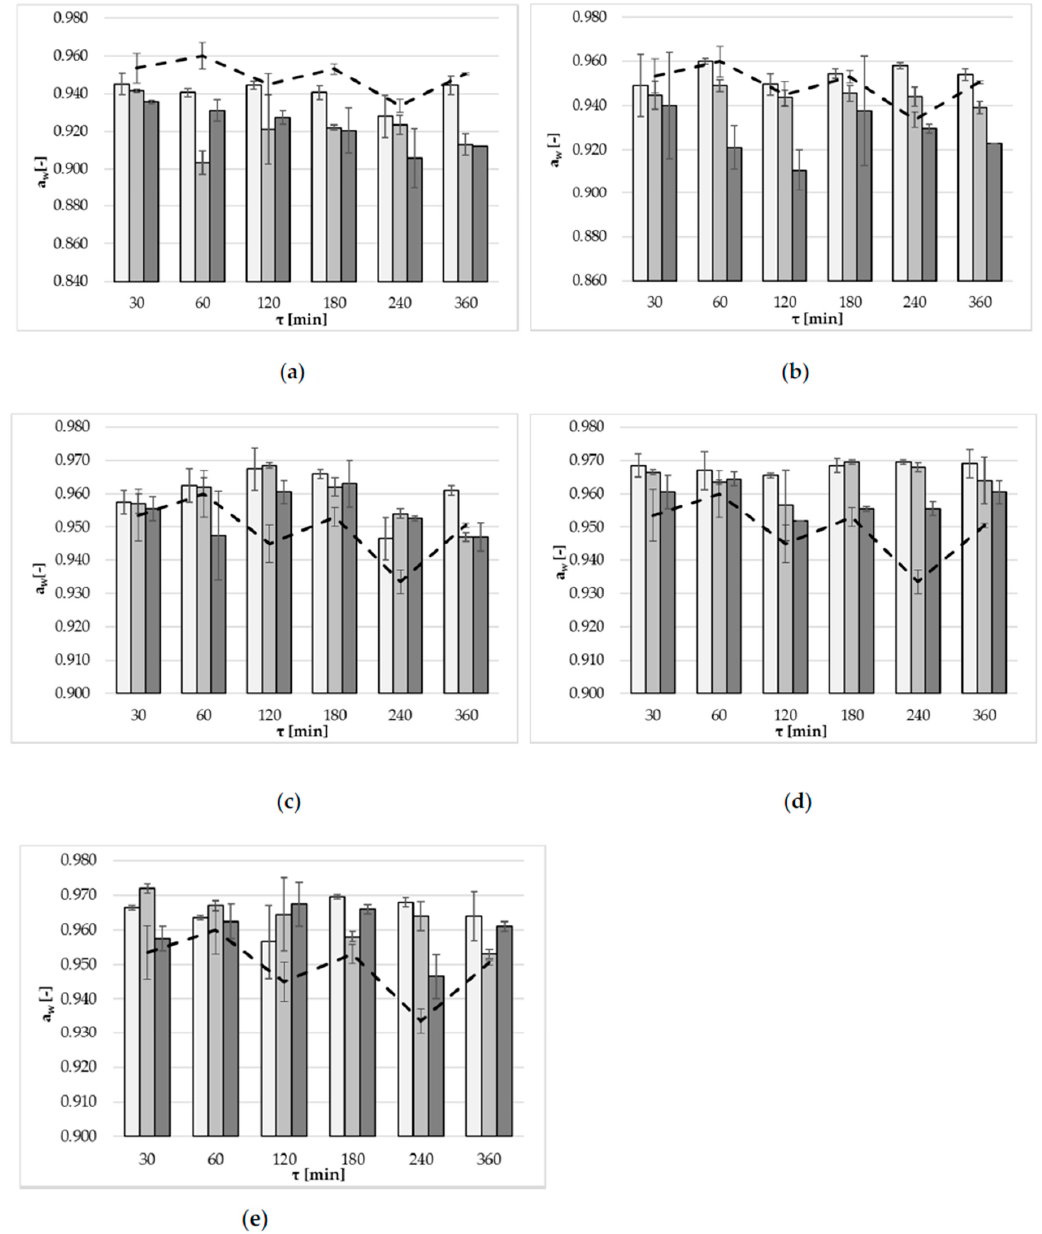
Figure 3. Water activity, a w , at several concentrations: 20 (light grey bars), 30 (grey bars), 40 (dark grey bars) g/100 g at 40 ◦ C, using different solutions: ( a ) erythritol, ( b ) xylitol, ( c ) maltitol, ( d ) inulin, ( e ) oligofructose. The dotted line marks the values of a w in a 50% solution concentration of